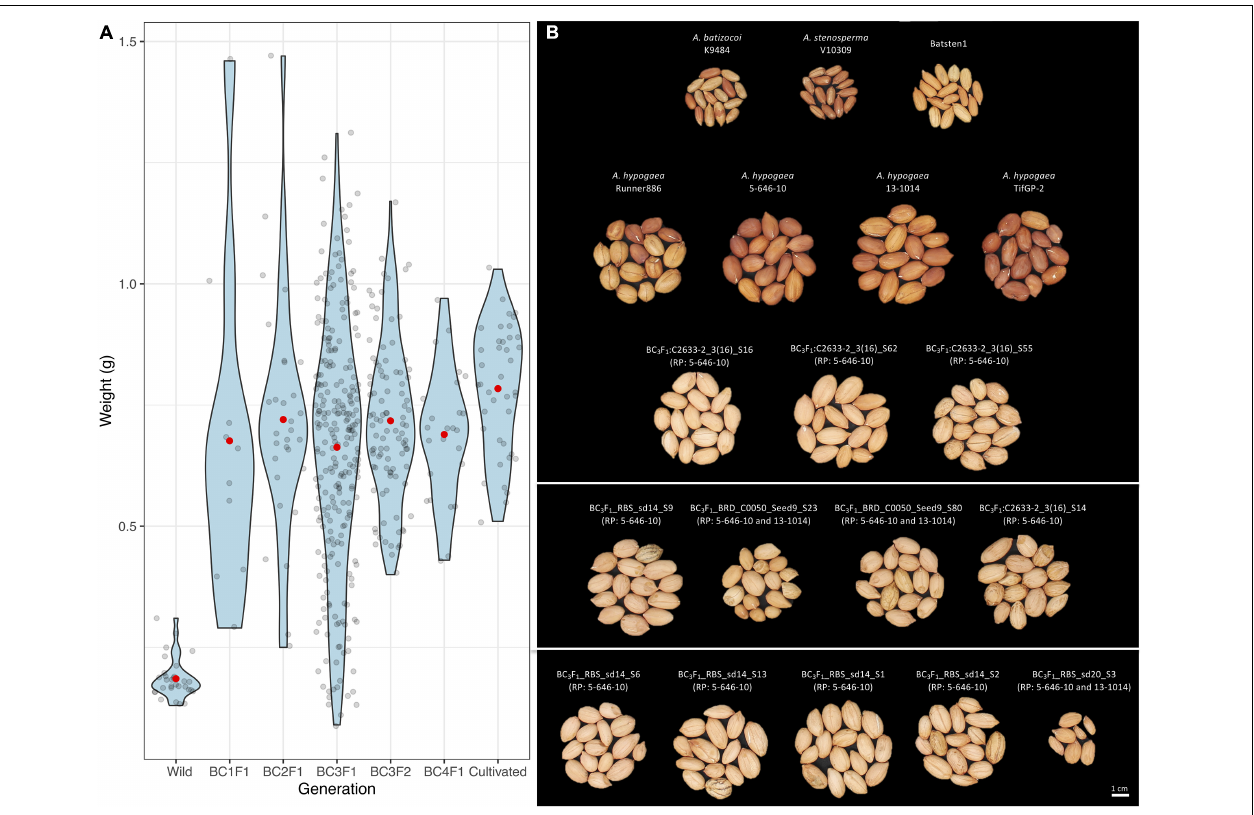
FIGURE 5 | Violin plots for the distribution of seed weight (g) (y-axis) for wild controls, several backcross generations (BC 1 F 1 s, BC 2 F 1 s, BC 3 F 1 s, BC 3 F 2 s, and BC 4 F 1 s) and cultivated genotypes (x-axis); Black dots indicate each individual line and red dot the mean (A) . Photo of seeds of diploid species ( A. stenosperma and A. batizocoi ), synthetic allotetraploid BatSten1, cultivated genotypes (Runner-886, 5-646-10, 13-1014, TifGP-2), and seeds from BC 3 F 1 lines (B) . Groups of 15 seeds are presented. Recurrent parent (RP) indicated in parenthesis for each BC 3 F 1 line. Complete pedigree in Supplementary Table 7 . The same trend for length (mm) and width (mm) was observed ( Supplementary Table 9 ). Refer to Table 2 for average, SD, and statistical analysis for